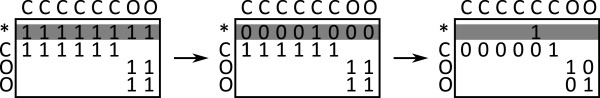
Iteration of Ullmann algorithm. One step of the Ullmann algorithm. The initial compatibility matrix (left) shows carboxylic acid substructure nodes as rows and heptonic acid molecule atoms as columns. A non-zero entry indicates the compatibility of a node-atom pair. Zero entries are not shown. In the current row, indicated in gray, the algorithm choses one compatible node-atom mapping (middle) and refines all unprocessed rows (right). The algorithm continues with the next row. Figure 3 illustrates the refinement.